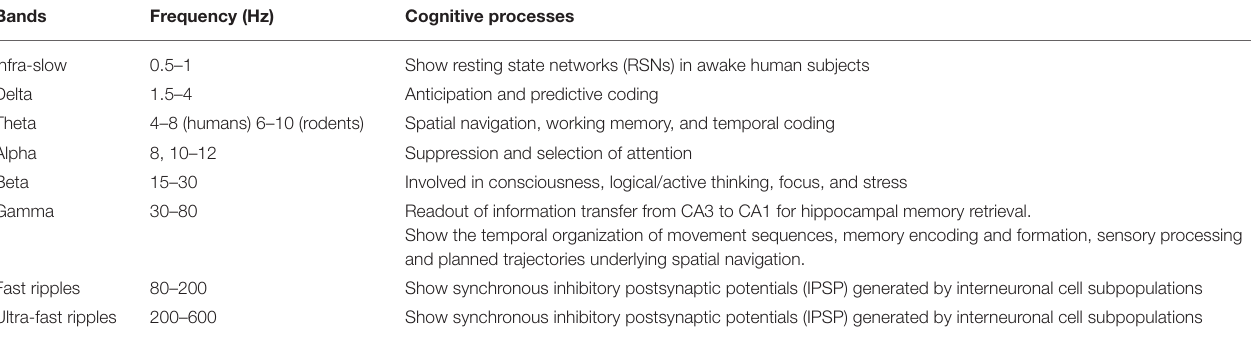
TABLE 1 | Frequency bands and cognitive processes.